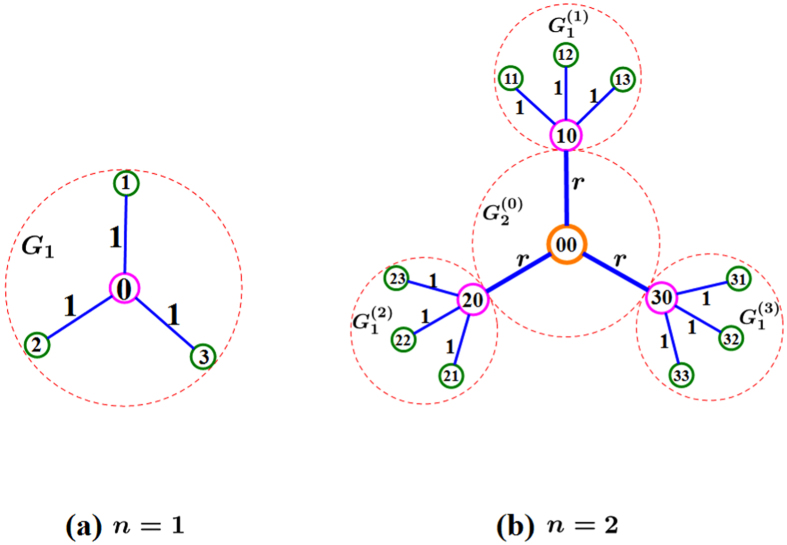
Take the ‘Sierpinski’ weighted fractal networks Gn, for example, G2 is regarded as merging , , , .